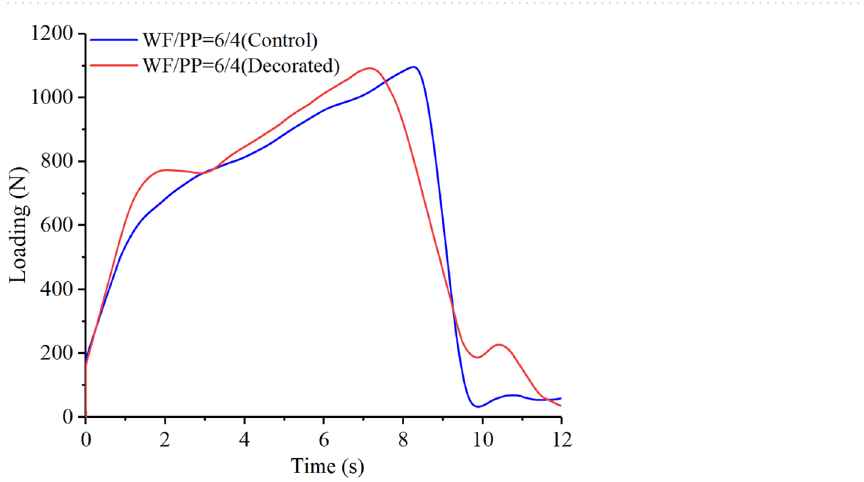
Figure 15. The low-velocity impact loading-time curve of the WF/PP = 6/4